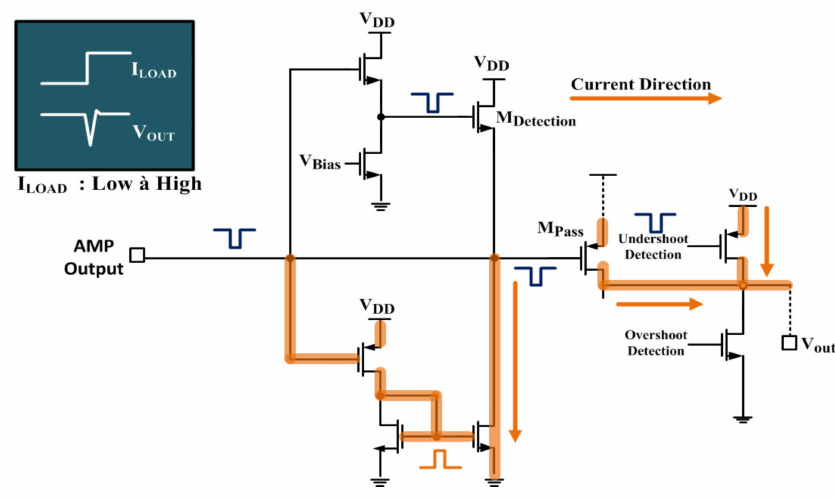
Figure 3. Current Driving Buffer Structure with undershoot in the proposed LDO regulator.